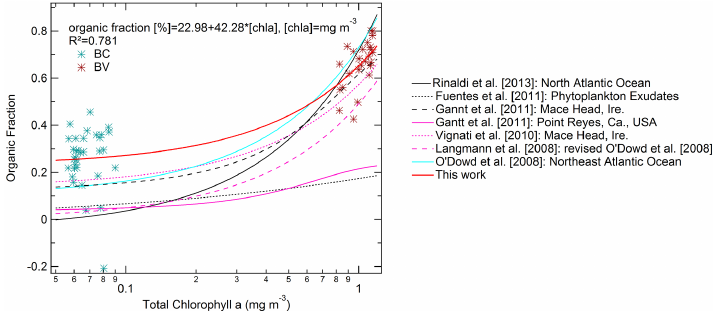
Figure 7. Organic fraction calculated from kappa ( κ org = 0.006 and κ inorg = 1.25) at SS = 0.39% vs. total chlorophyll a concentrations (mgm − 3 ) for all three mesocosms during both BC and BV, fit with published parameterizations of the organic fraction-chla relationship.